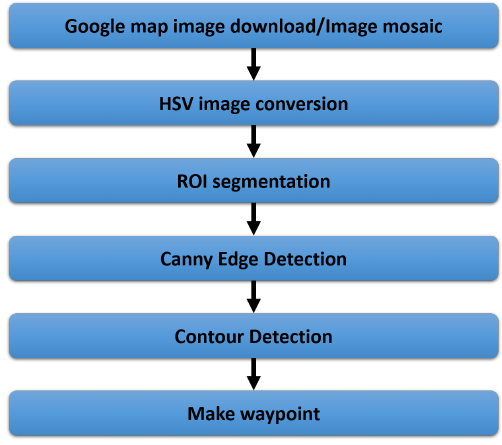
Figure 5. Block diagram of the flight planning